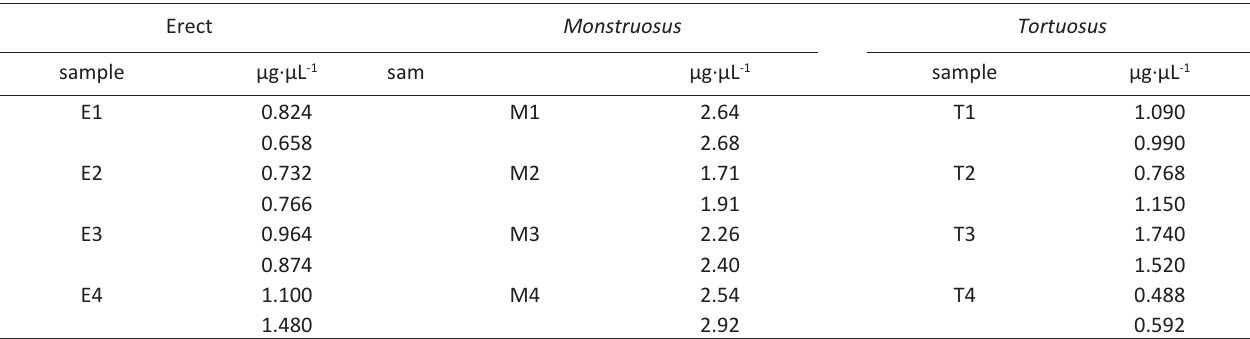
Table 1 ­ Protein quantification (µg µL ­1 ) by the fluorometric method in duplicate of morphological variants of Cereus with shoots erect (E1­E4), monstruosus (M1­M4), and tortuosus (T1­T4) obtained by the extraction with TCA/acetone method described by He and Wang